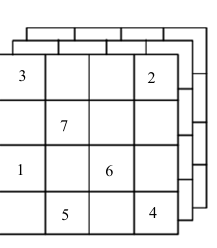
Fig. 4 Octal Gaussian random measurement matrix. The value of matrix elements ranges from 0 to 7, in which the element corresponding to the part not marked with value is 0.